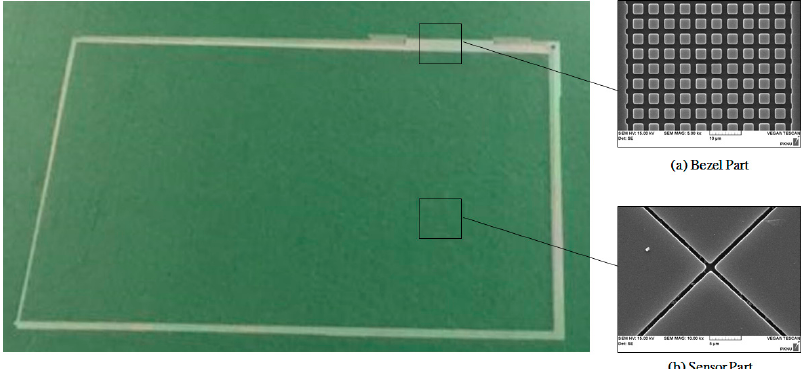
Figure 2. Touch sensor panel and scanning electron microscope (SEM) images of engraved ( a ) bezel electrodes and ( b ) sensor electrode patterns made by UV imprinting process with embossed metal mold.